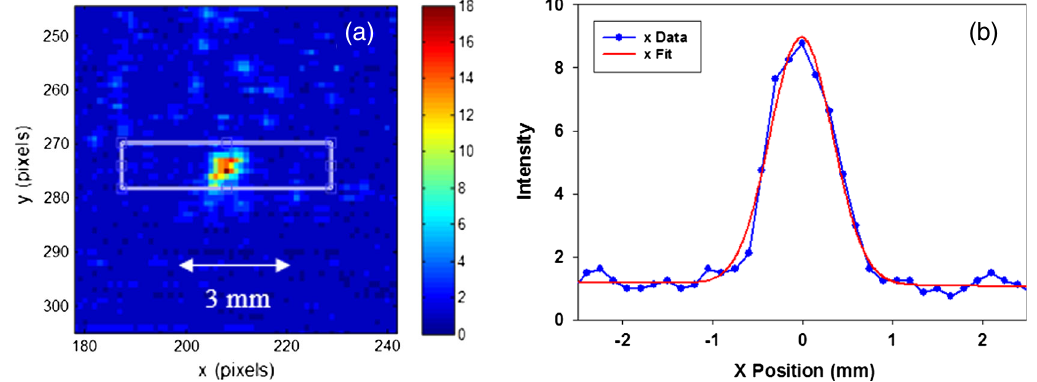
FIG. 5. (a) Streak camera focus mode 50-image sum with median background value subtracted with four electrons stored at 375 MeV; (b) projected x profile (blue curve) from the vertically narrowed ROI and the Gaussian profile fit (red curve). A pseudocolor intensity scale is shown at the right of the